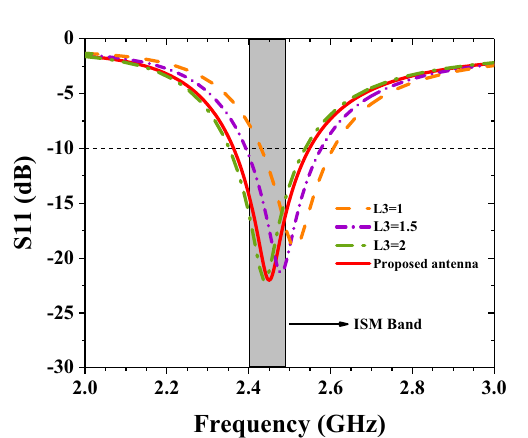
Figure 6. The effect of antenna L3 length on S11.